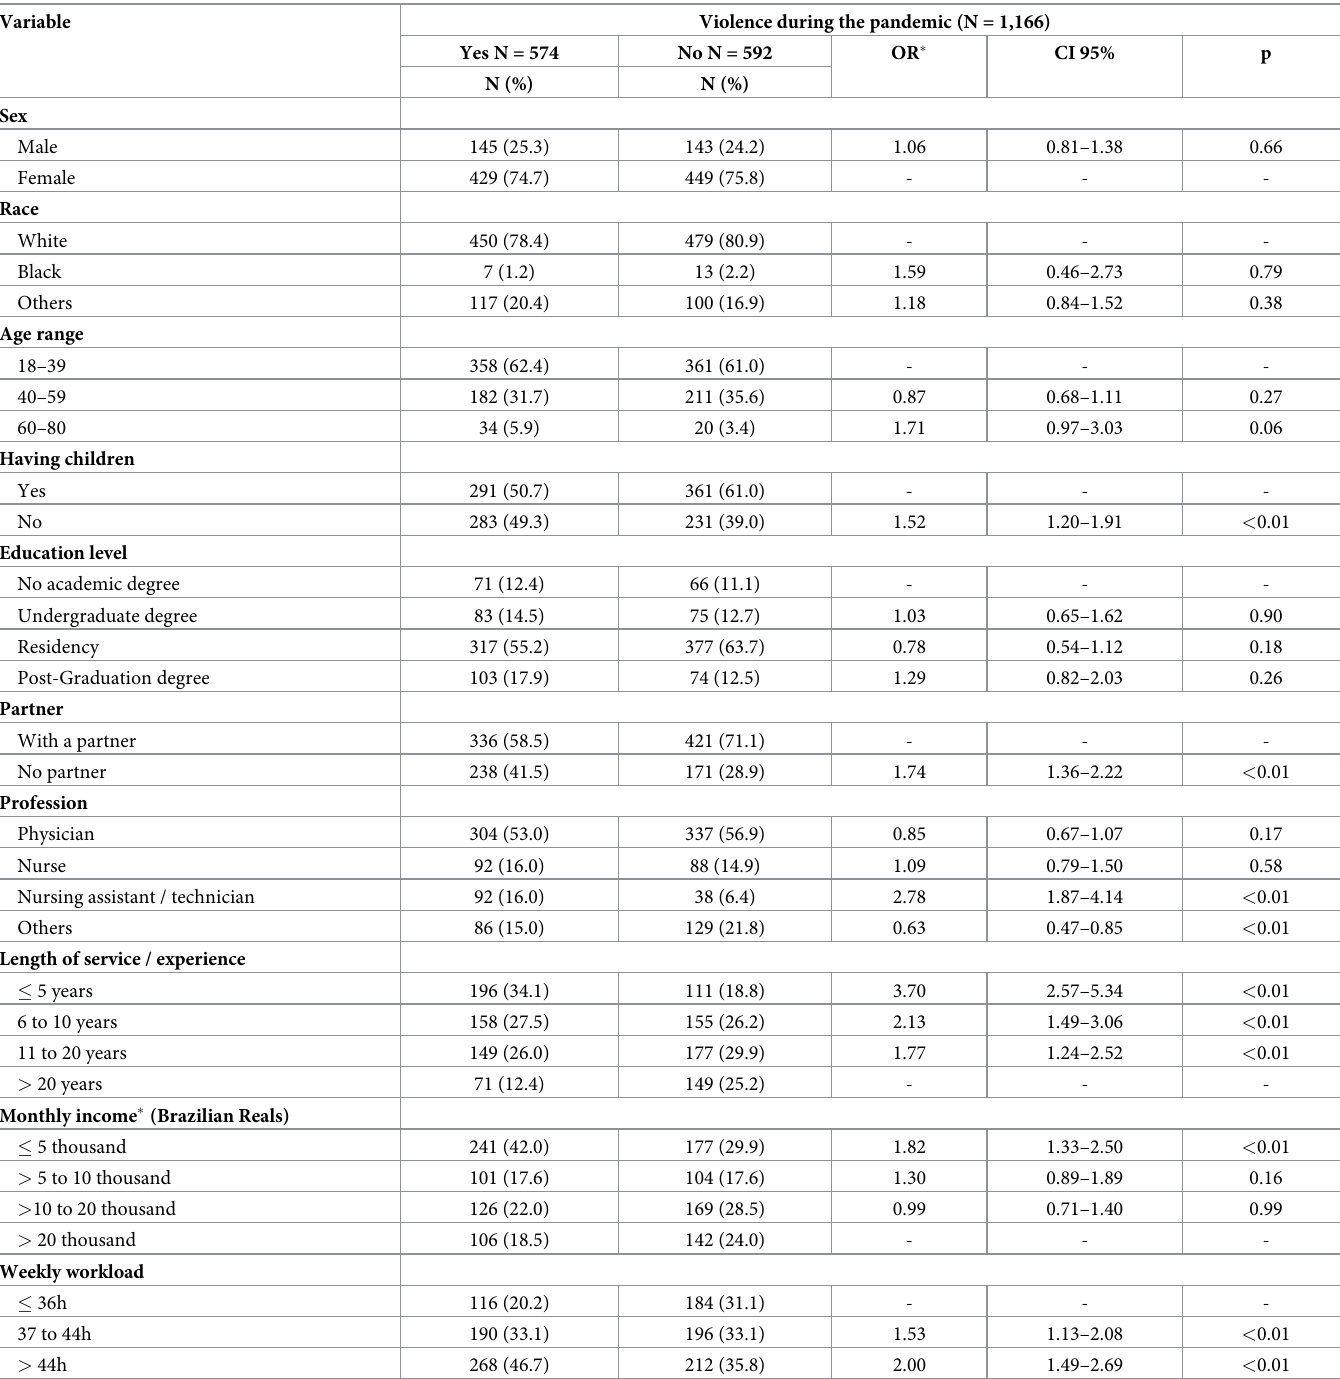
Table 3. Correlation of sociodemographic and professional factors with the risk of violence in the